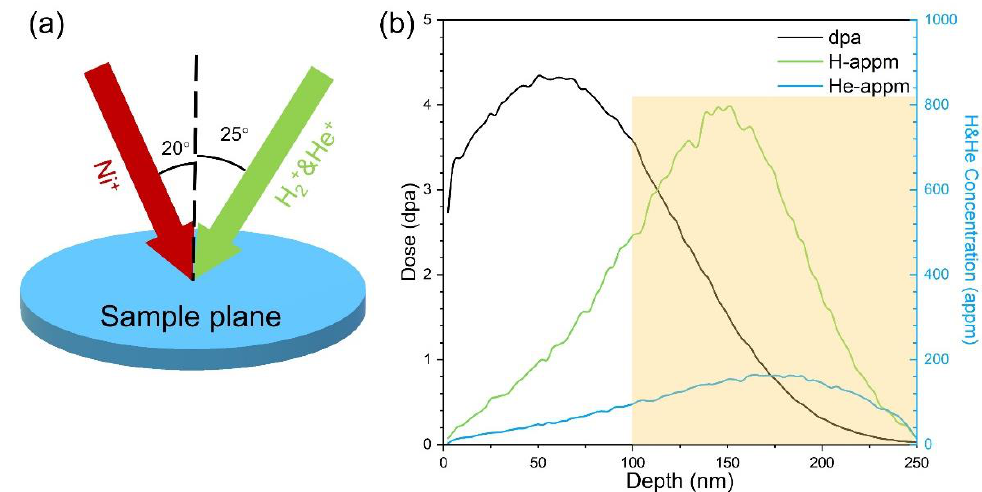
Figure 1. ( a ) Schematic diagram of the geometric relationship between sample and beamlines; ( b ) The SRIM profiles of displacement damage (left axis) and gas concentration (right axis) in pure nickel under MSIB irradiation. The triple ion beams included 400 keV Ni + and 50 keV He + & H + The orange box represents the examination region at a depth of 100–250 nm below the surface, where average accumulative dose and gas concentration was ~1 dpa, ~400 appm H and ~100 appm He.